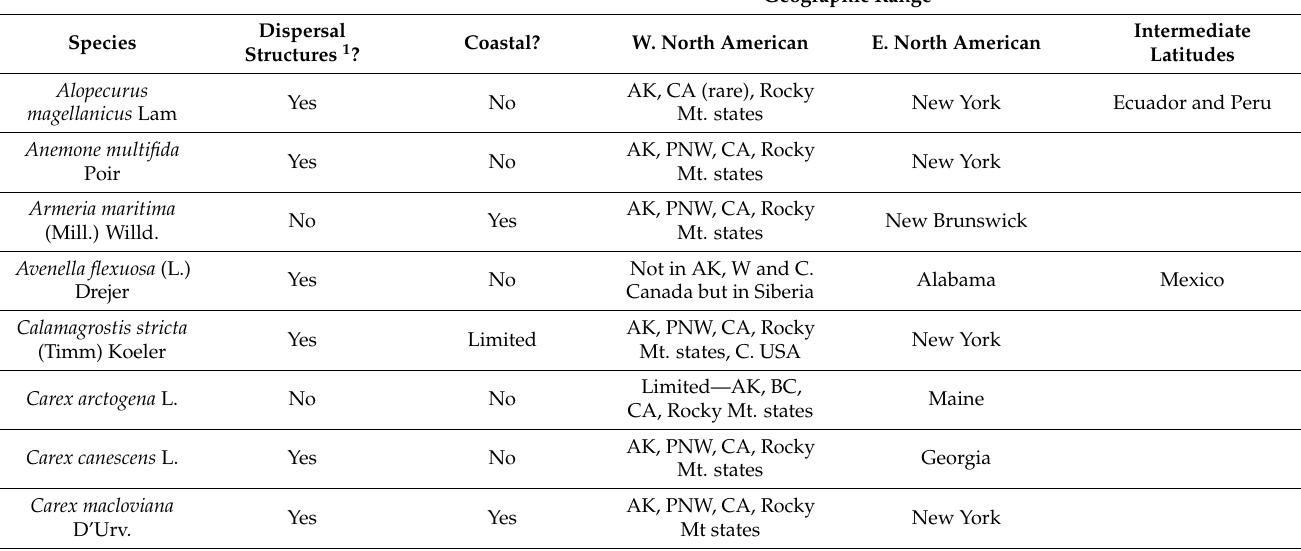
Table 1. Geographical ranges of the bipolar plant species. Source—Herbarium specimen records of the Global Biodiversity Information Facility (https://www.gbif.org/ (accessed on 20 January 2022); GBIF,